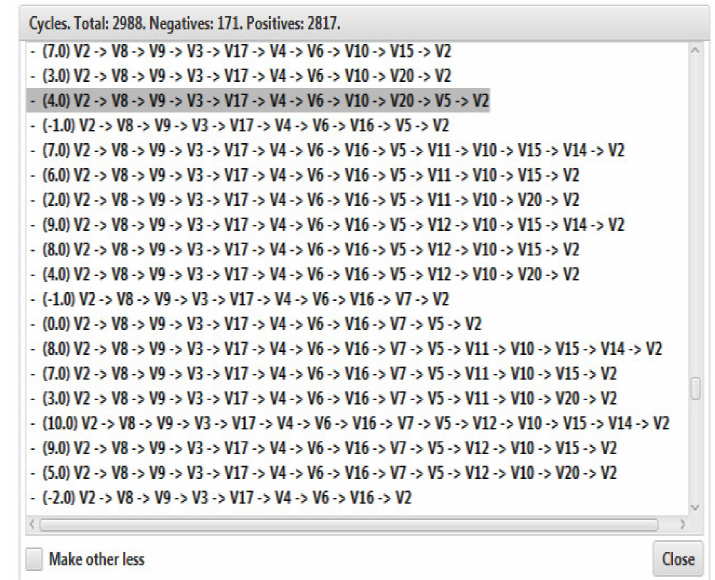
Figure 4. “Negative” cycle selection of the regional system relationship (fragment from the computer data processing results on the program CMSS).